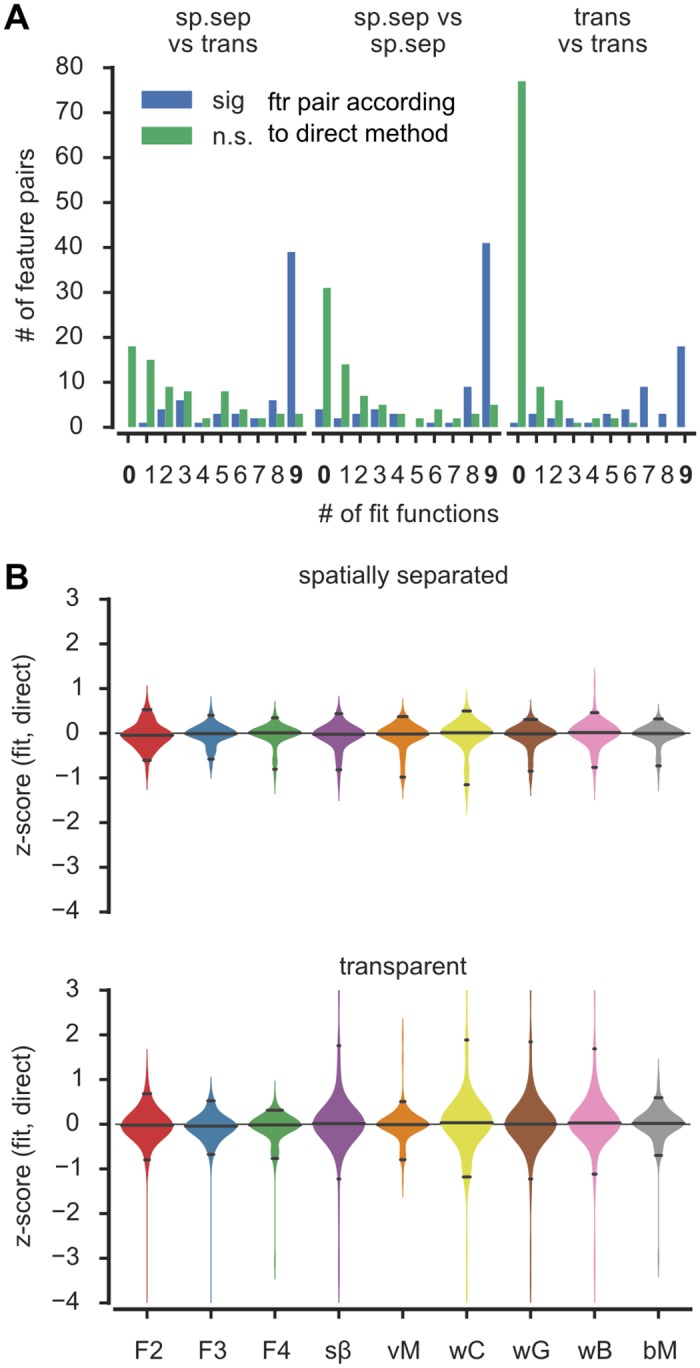
Direct method yields very similar results as fits.A) Layout is similar to Fig 5B. Each bar from there was split into two, depending on if a considered feature pair was judged significantly different (blue) or not (green) when evaluated with the direct method. The panel illustrates a strong tendency to find a significant effect with either both the direct method and all nine models, or with neither the direct method and none of the models. B)
z-scored quantitative differences between direct and fitted method’s feature values is less than one standard deviation for almost all features independent of the model indicating a considerable quantitative agreement between the methods. Solid lines in violines mark 2.5%, 50% and 97.5% quantiles. Color code and model abbreviations are as in Figs 3 and 5.